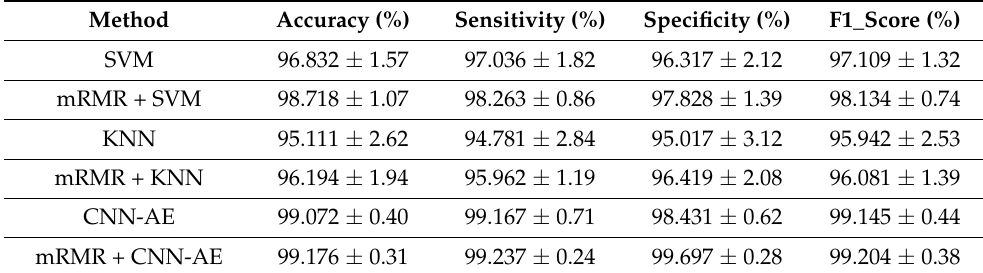
Figure 7. Results for the Bonn Dataset. ( a ): set A-E, ( b ): Set B-E, ( c ): set C-E, ( d ): set D-E, ( e ): set ABCD-E, ( f ): set AB-CD-E.